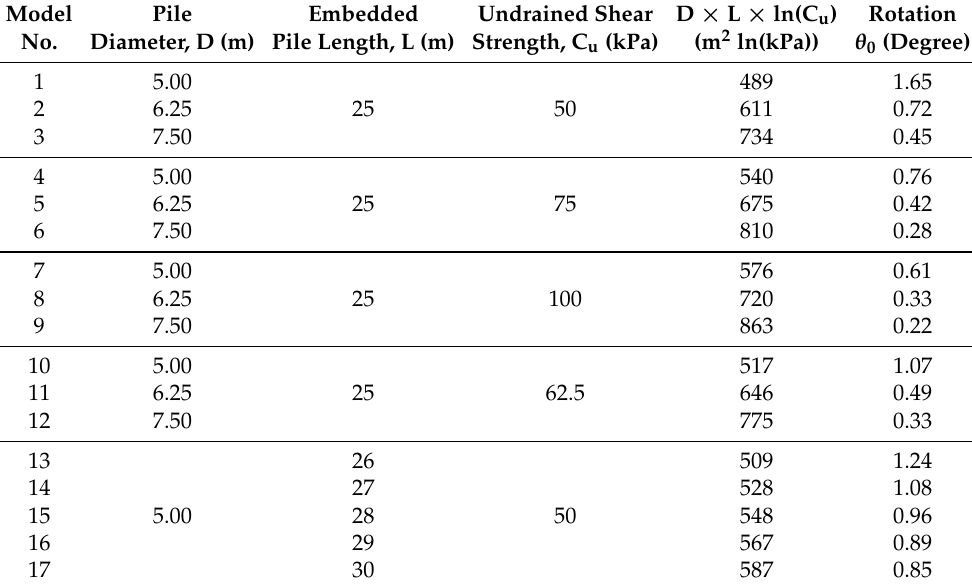
Table 10. Pile rotations in the first cycle for the 17